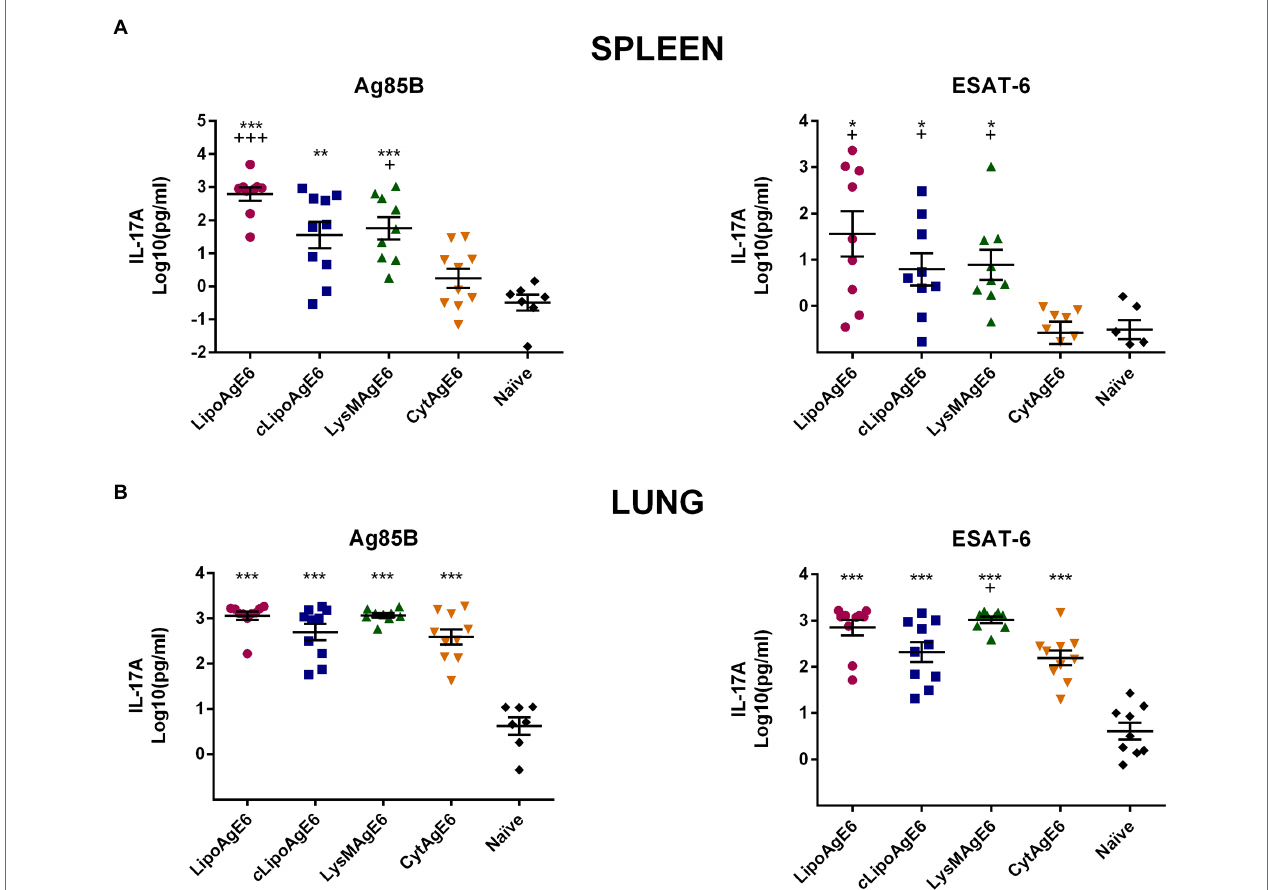
FIGURE 8 | The concentration of secreted IL-17A in supernatants of splenocytes and total lung cells (TLC) induced by recall antigens Ag85B or ESAT-6. Splenocytes (A) and TLC (B) from immunized mice were stimulated with Ag85B or ESAT-6 for 5 days, after which levels of secreted IL-17A were quantified by ELISA. Results are presented as a mean ± SEM of samples ( n = 6–10). Statistically significant differences were determined using one-way ANOVA with Games- Howell post-hoc test. Significant differences between either of the candidates and naïve mice or CytAgE6 are marked with * and +, respectively. * /+ p < 0.05, ** /++ p < 0.01, and *** /+++ p <